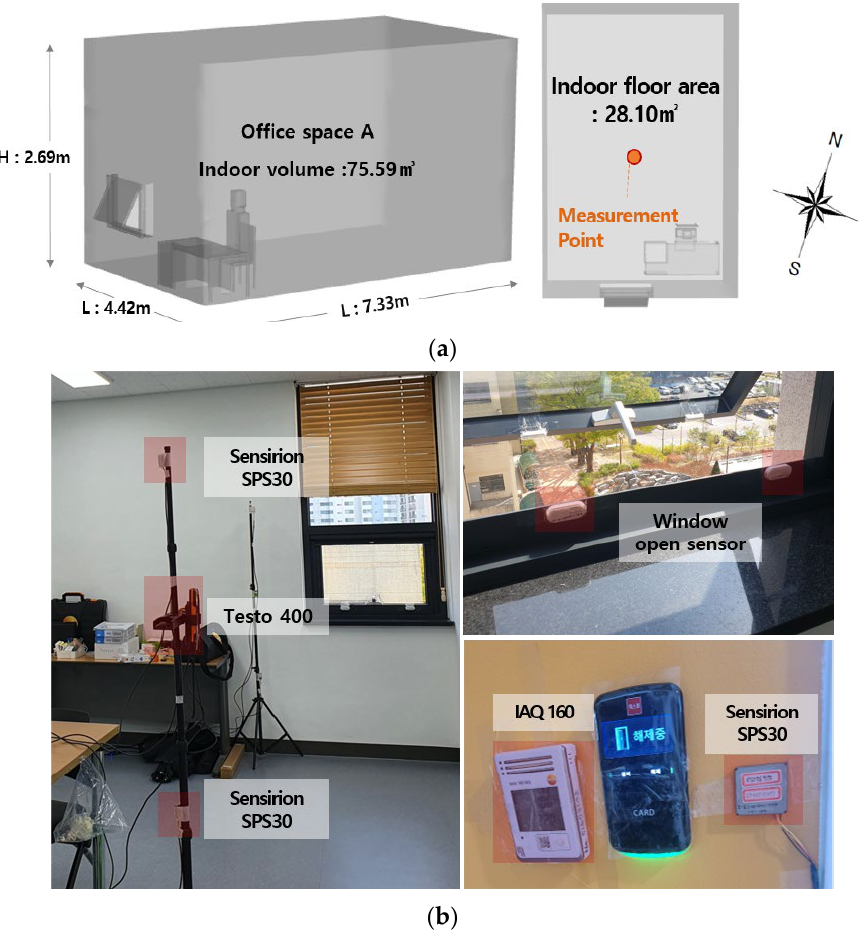
Figure 5. Indoor air quality measurement of a one-person office space: ( a ) one-person office space plane view and measurement locations, and ( b ) photos of the indoor air quality measurement experiment on 20 April 2021.